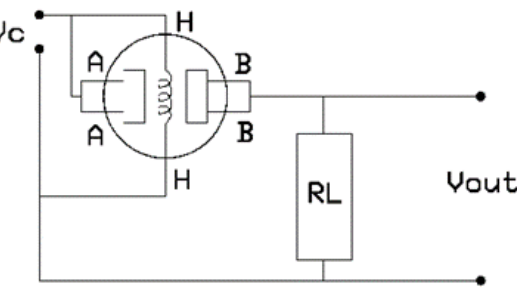
Figure 1. Gas sensor driving circuit schematics.